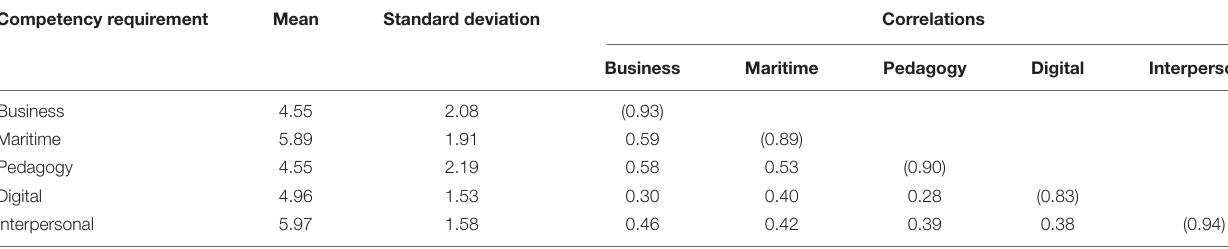
TABLE 6 | Descriptive statistics, reliability and Pearson’s correlations.